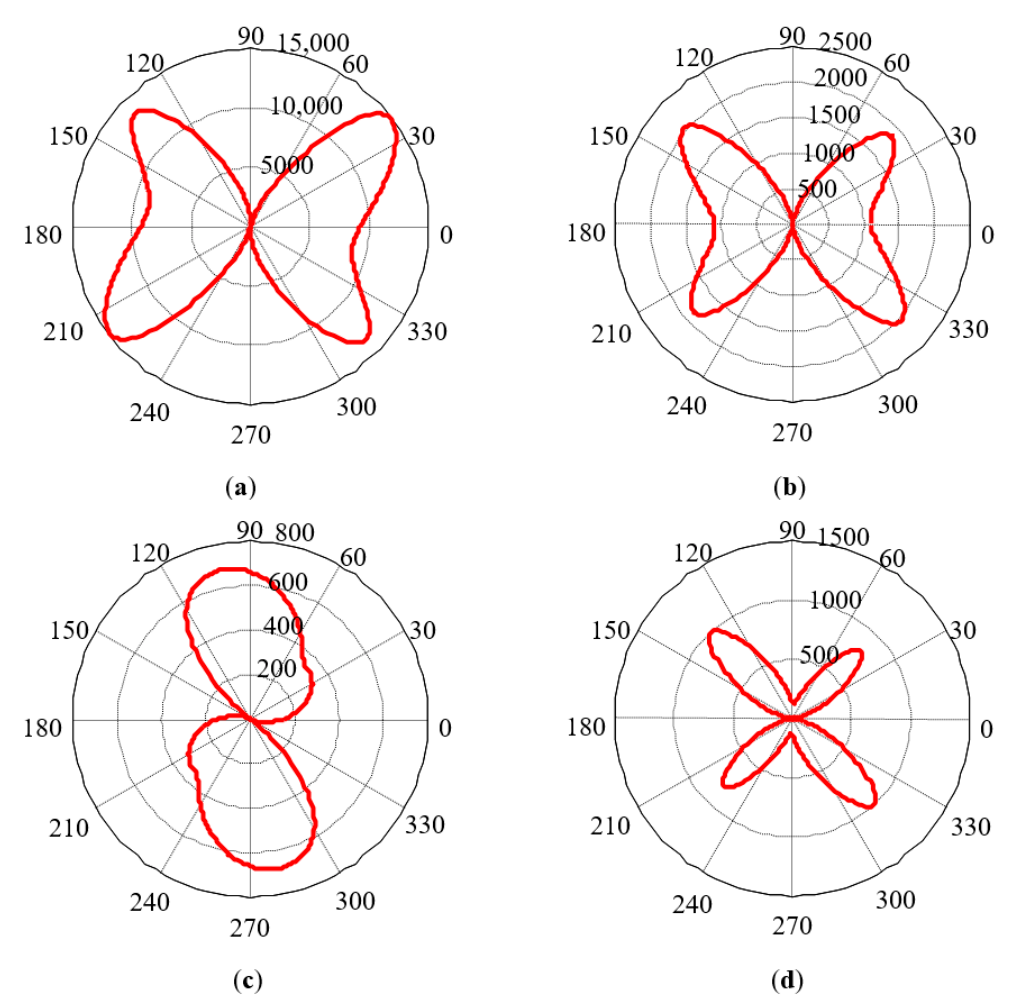
Figure 13. Simulation results of MCE in 4 materials: ( a ) 30SQG120, ( b ) B50A470, ( c ) X60, and ( d ) X70.